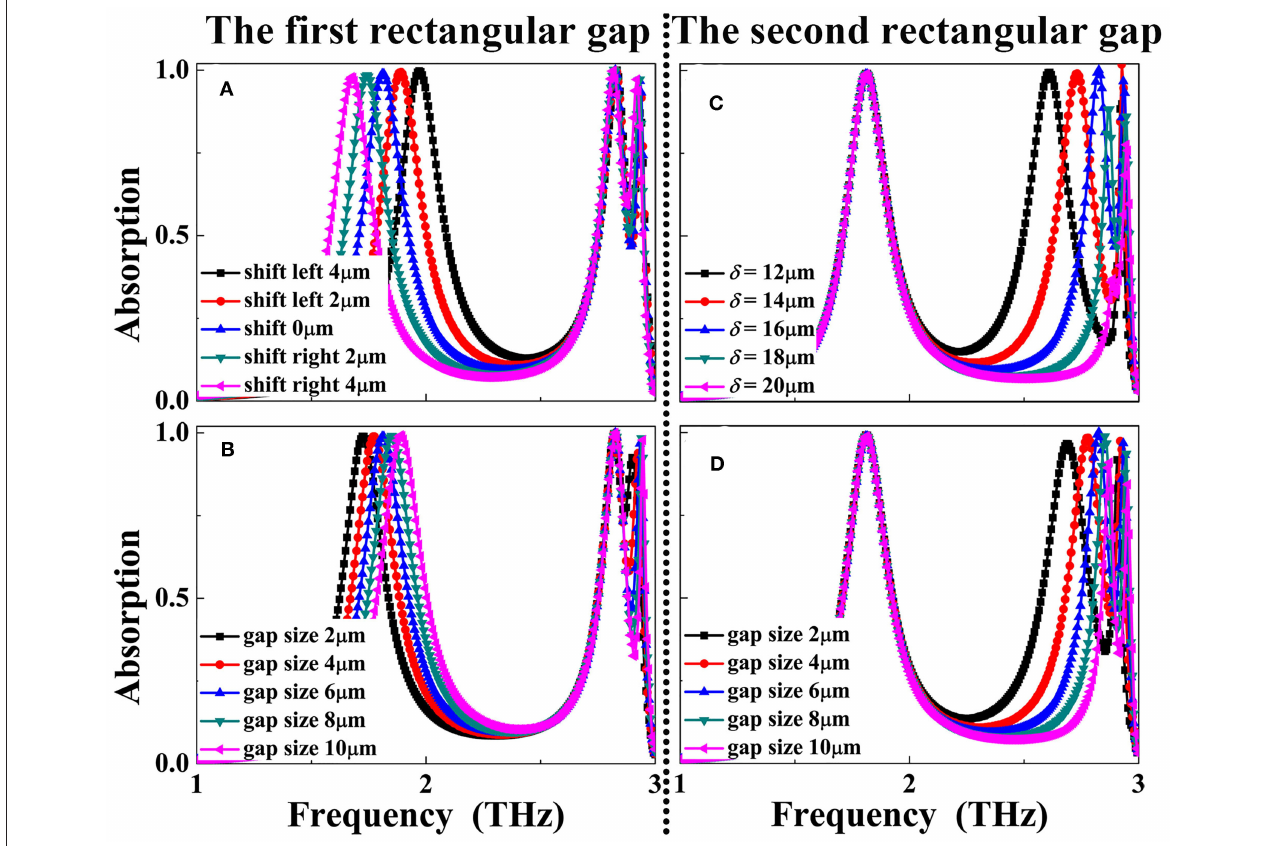
FIGURE 8 | Dependence of the absorption response of the triple-band metamaterial absorber on the size changes of the left (or first) air gap position ( δ ) in (A) , gap ( g ) in (B) ; Dependence of the absorption response of the triple-band metamaterial absorber on the size changes of the right (or second) air gap position ( δ ) in (C) , gap ( g ) in (D)